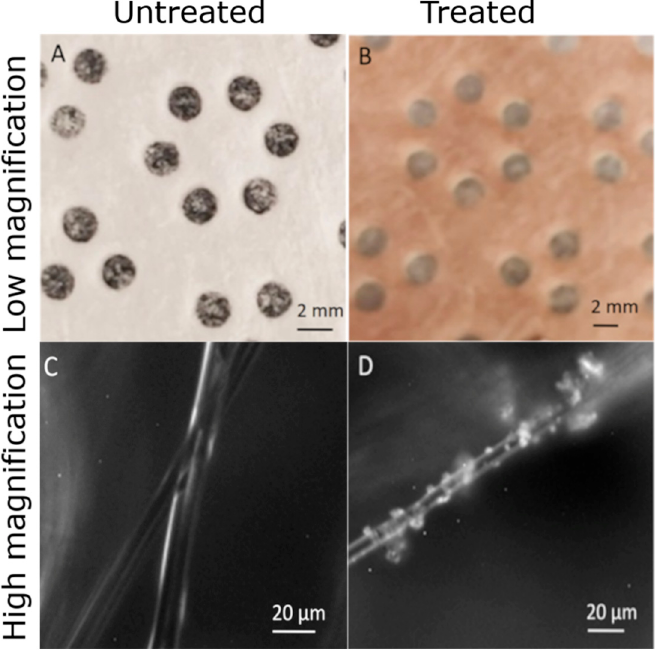
Figure 1. Light microscopy images of polypropylene materials at the macroscopic scale ( A , B ) and microscopic scale ( C , D ). The circular holes were in the original fabric and would not be present in all applications. After heat treatment, the attached 2 µm Cu 2 O particles impart a red-brown color on a macroscopic scale, and the particles can be seen on a microscopic scale.